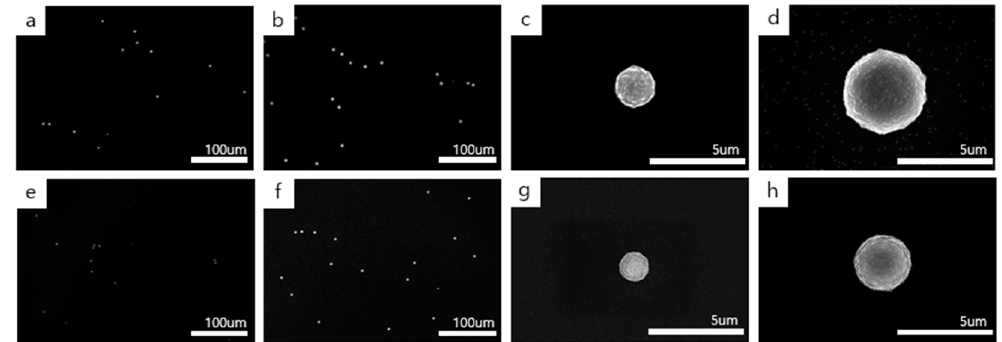
Figure 3. FE-SEM images of diamond particles deposited on the Si substrate at a filament temperature of 1900 ◦ C. ( a , b ) show the low magnification images of diamond particles deposited for 4 h and 8 h, respectively, at 1% CH 4 –99% H 2 , with ( c , d ) being the respective high magnification image. ( e , f ) show the low magnification image of diamond particles deposited for 4 h and 8 h, respectively, at 3% CH 4 –97% H 2 , with ( g , h ) being the respective high magnification image.